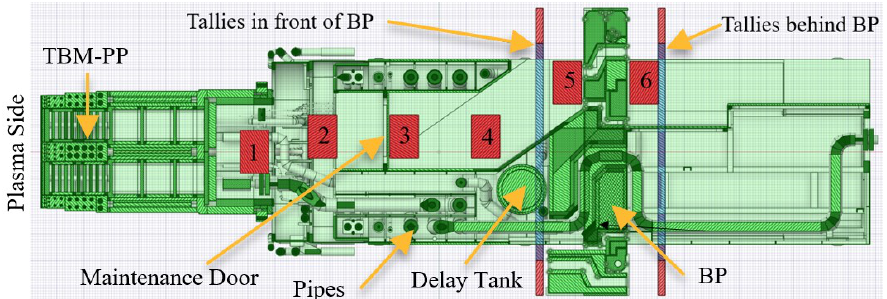
Figure 14. Human-sized and BP